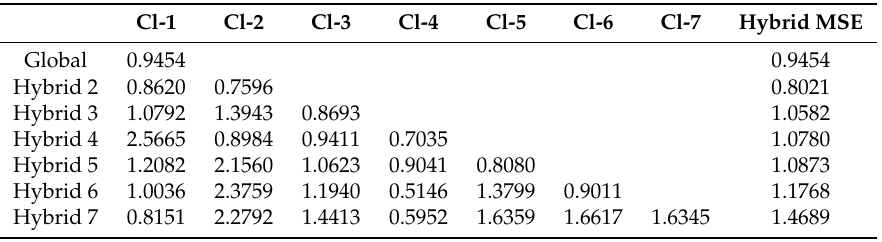
Table 4. MSE per cluster in the model to predict the power at